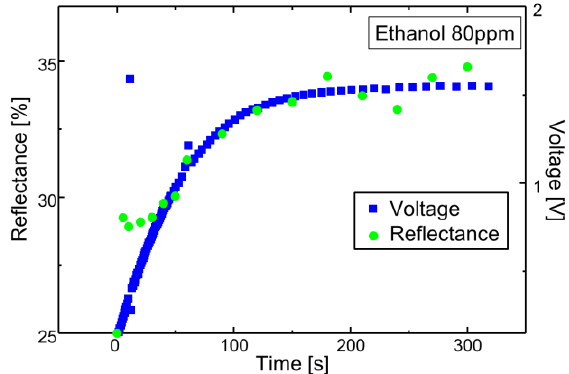
Figure 10. Comparison between reflectance and readout voltage.